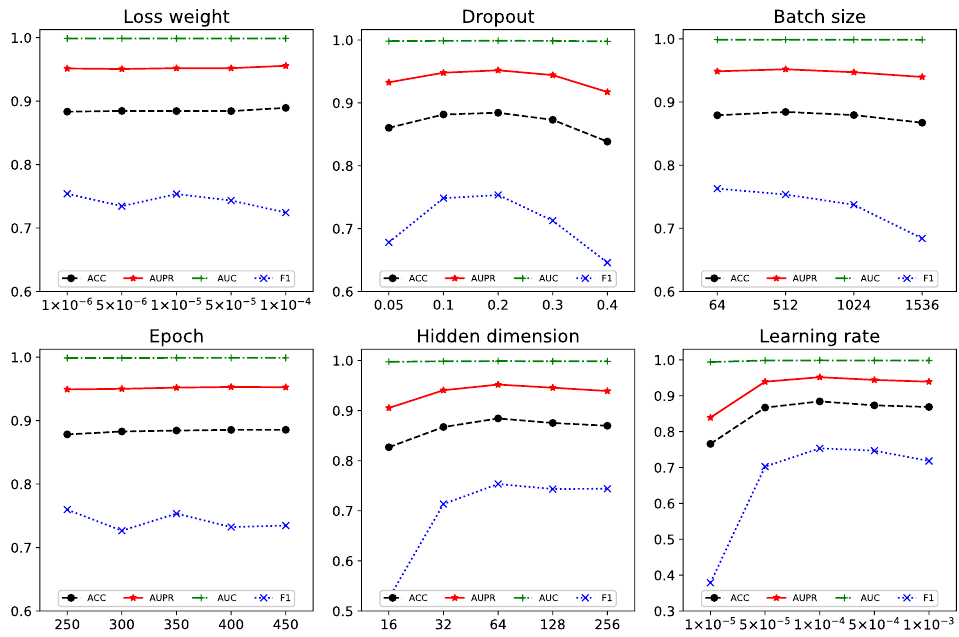
Figure 1. The metric scores under different hyperparameter settings on Dataset 1.